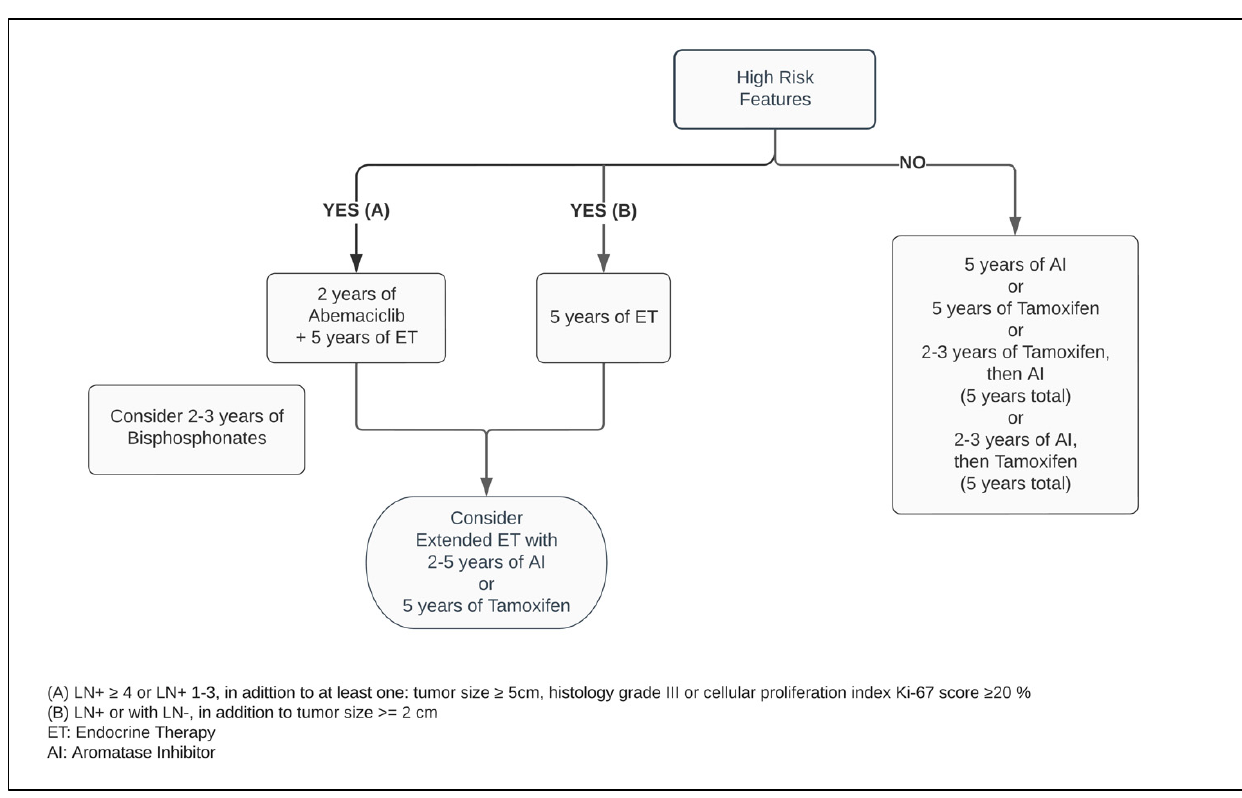
Figure 2. Adjuvant endocrine therapy for postmenopausal women with ER+ HER2 − breast